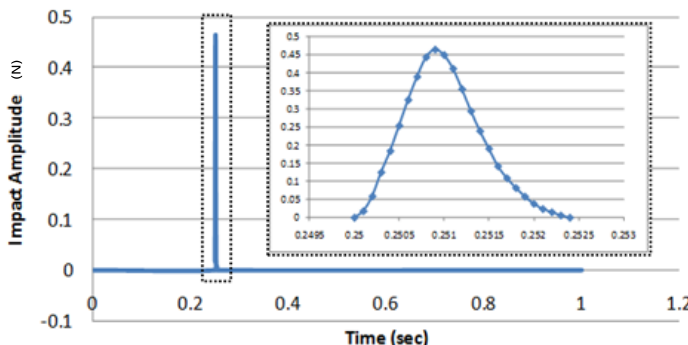
Fig. 15. Forcing pulse used for BU